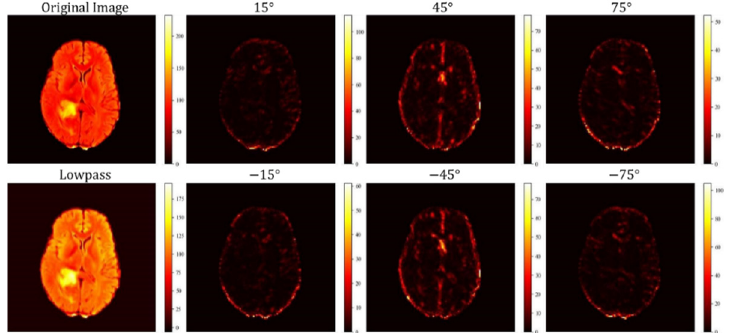
Figure 2. Visualization of the first-order dual-tree complex wavelet scattering transform of brain tumor MRI images.